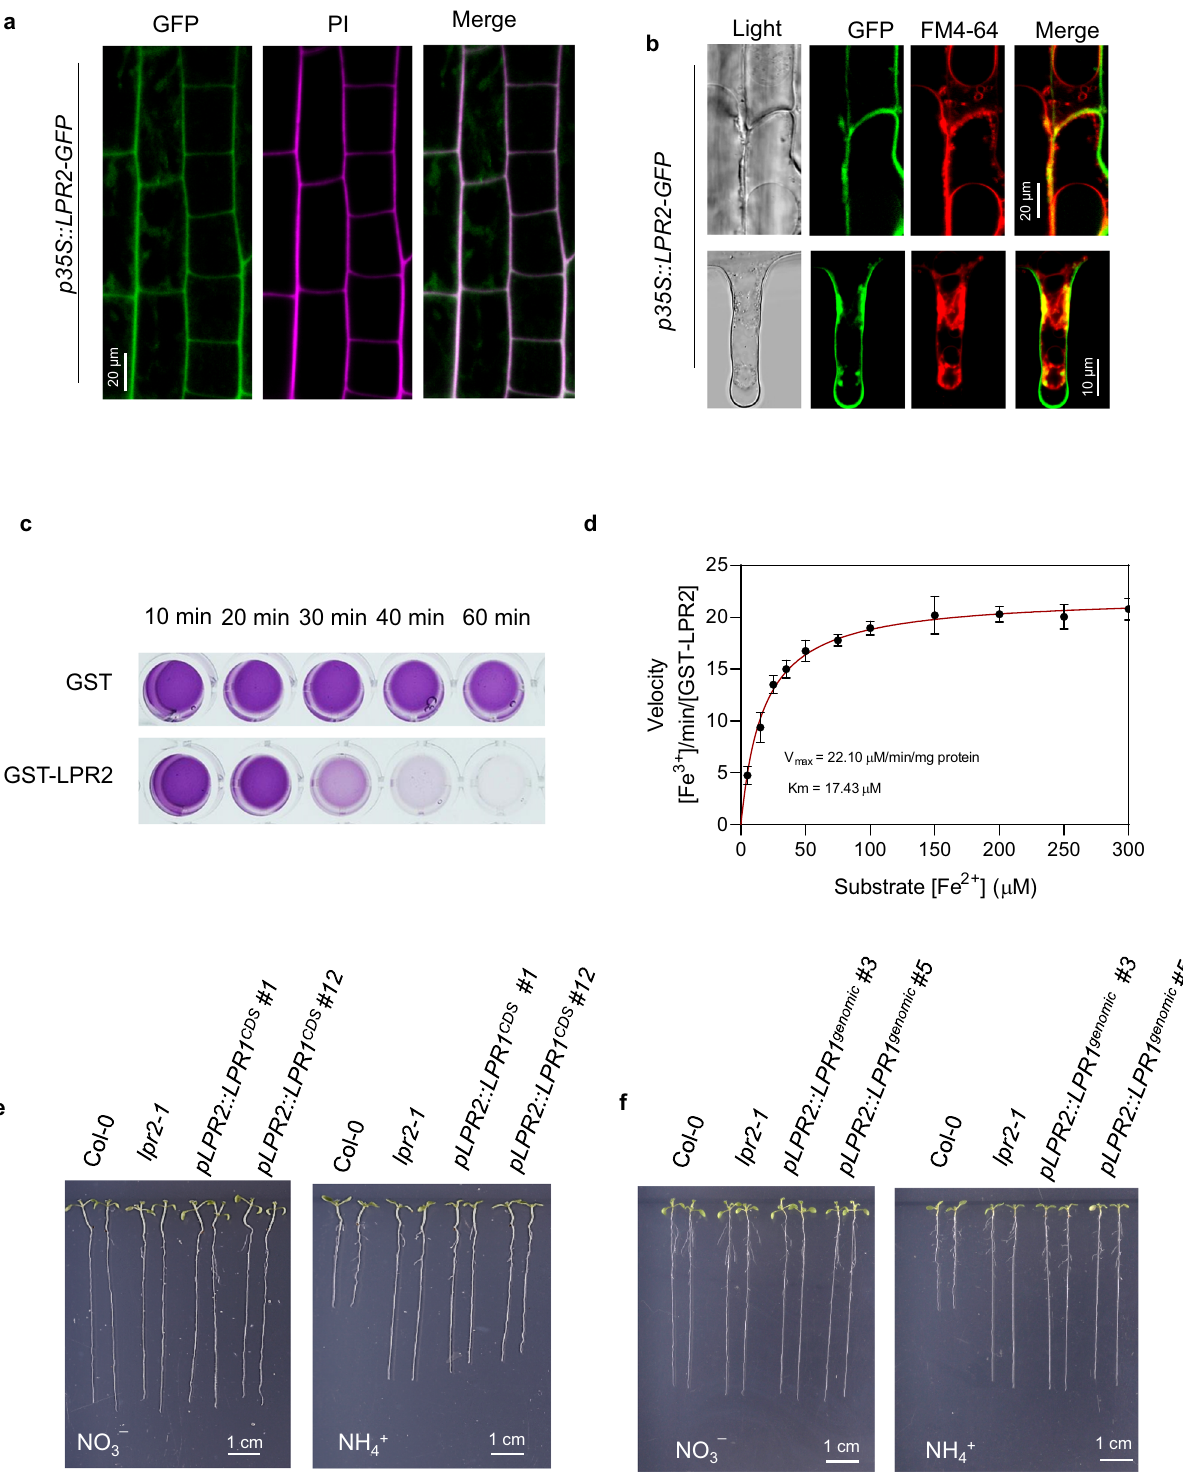
Fig. 2 LPR2 is a cell wall ferroxidase and is irreplaceable by LPR1. a Fluorescence co-localization of LPR2-GFP and propidium iodide in cells of p35S::LPR2- GFP roots. b Fluorescence of LPR2-GFP and FM4-64 in cells of p35S::LPR2-GFP roots after plasmolysis with 0.8 M sorbitol. Four-day-old seedlings were transferred to NH 4 + medium with 100 µ M Fe, and confocal analyses were performed 4 days after seedling transfer. c Ferroxidase activities of recombinant GST-LPR2. Ferroxidase assay using 1 μ g puri fi ed GST-LPR2 protein. Pink indicates the Fe 2 + -ferrozine complex. The substrate Fe 2 + was added in the form of Fe(NH 4 ) 2 (SO 4 ) 2 ·6H 2 O at an initial concentration of 50 μ M. d Fe 2 + concentration-dependent (0 – 300 μ M) ferroxidase activity of GST-LPR2 protein. Data shown are mean ± SD of three biological replicates. e , f Phenotype of lpr2-1 mutant lines with LPR2 promoter-con fi ned tissue-speci fi c expression of LPR1 CDS and LPR1 genomic . Four-day-old seedlings of the indicated genotypes were transferred to NO 3 − or NH 4 + medium with 100 µ M Fe and analyzed 4 days after seedling transfer. Two ( c , d ) or three ( a , b , e , f ) independent experiments were performed with similar results, and one representative experiment is